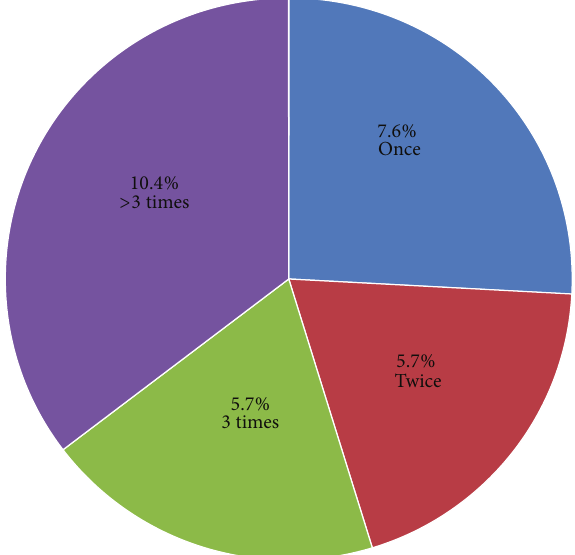
Figure 3: Frequency of use of personal protective equipment during emergency care provision by healthcare workers in the last 12 months in Debre Berhan town,